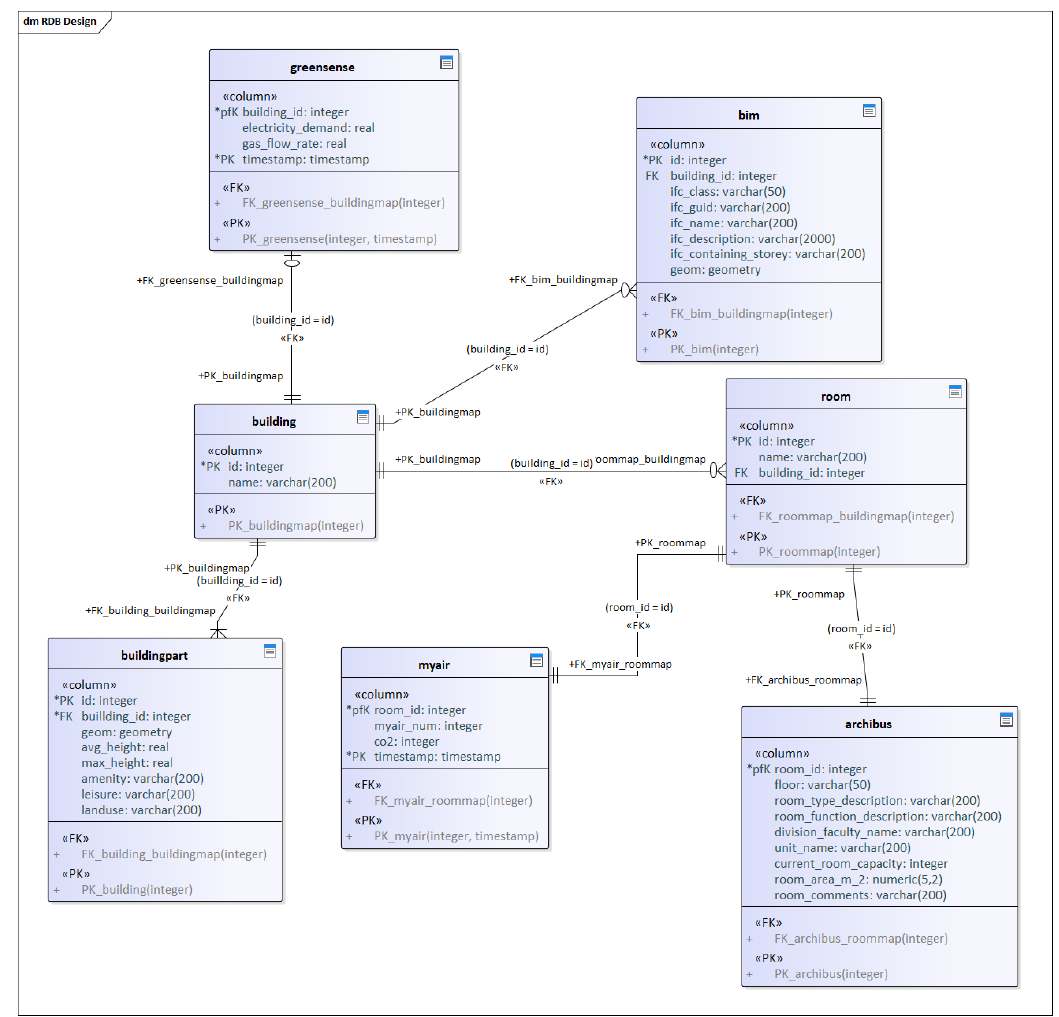
Figure 7. Logical data model for our relational database design.